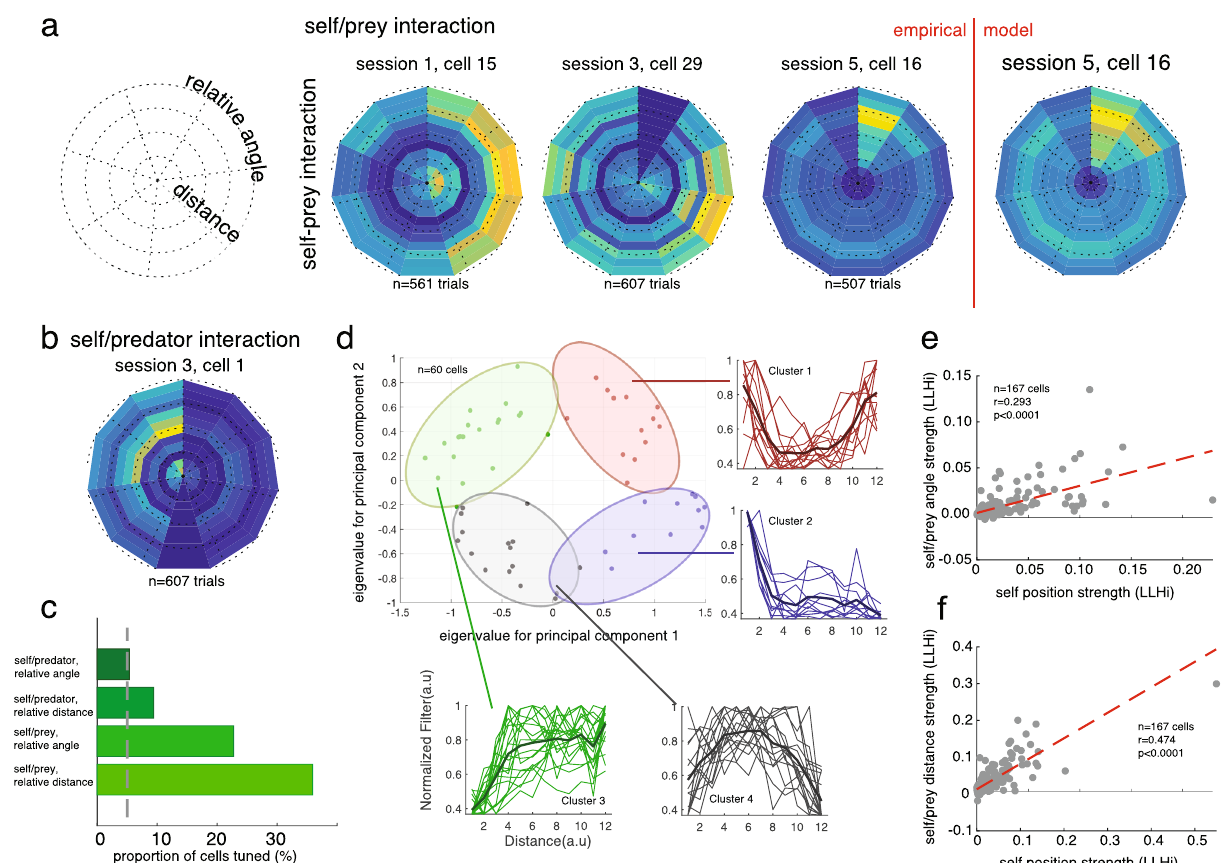
Fig. 5 Avatar-centric tuning in dACC. a Three example neurons and model fi t for self-prey avatar-centric variables (angle and distance). Each radial plot shows the responses of a single neuron to prey located at several distances (radial dimension) and angles (angular dimension) relative to the agent ’ s avatar. Horizontal right direction (0°) re fl ects distance in front of the direction the avatar is currently traveling; horizontal left (180°) indicates travel away from the prey. b Example neuron tuned for self-predator avatar-centric variables using same conventions as in a . c Proportion of neurons tuned for each of four avatar-centric variables. d Clusters of relative distance tuning functions (conventions as in Fig. 4). Scattergram re fl ects results of principal components analysis (PCA). Clusters 3 and 4 are ditonic; their existence argues against low-level explanation in terms of arousal or reward proximity. e , f Correlation between log-likelihood increase (LLi) for self position vs. self/prey distance ( e ) and angle ( f ). Each dot corresponds to one neuron. Positive correlation indicates that neurons selective for one variable tend to be more selective for another one. That in turn implies that tuning for the two variables comes from a single larger population of cells (or from highly overlapping populations) rather than distinct